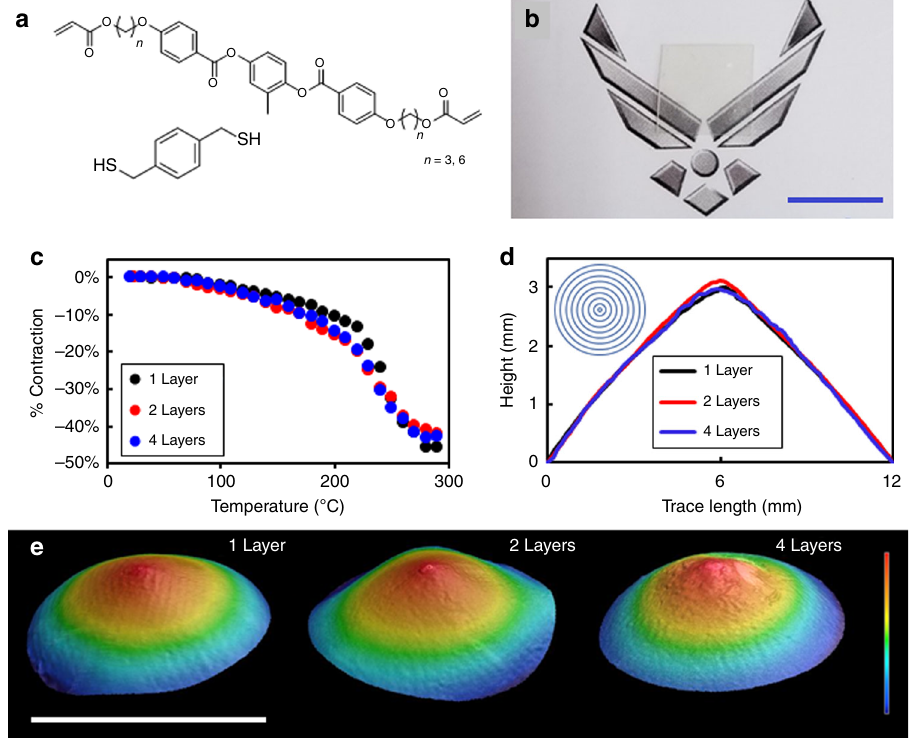
Fig. 1 Unloaded deformation of LCE laminates. a Chemical structures of: (1) the liquid crystal monomers (RM257, RM82) and (2) the dithiol additive. A mixture of 7:2 wt:wt of RM257:RM82 formed the basis of the liquid crystal elastomers (LCEs). b A 4 layer LCE laminate is optically clear. Scale bar is 1 cm. c The deformation of one, two, and four layer LCE laminates was measured in homogeneously aligned LCE fi lms. 50% strain is observed in all three samples. d The height pro fi les for the single layer, double layer, and four layer LCE laminates are nearly identical over the 12 mm diameter of the fi lms. Horizontal scale bar is 12 mm, vertical scale bar is 3.4 mm. e Height pro fi les of LCE laminates in which the individual layers were subject to directed self- assembly to organize into radial + 1 topological defects. The LCE laminates were heated to 140 °C and imaged with an optical pro fi lometer to quantify the deformation to thermal